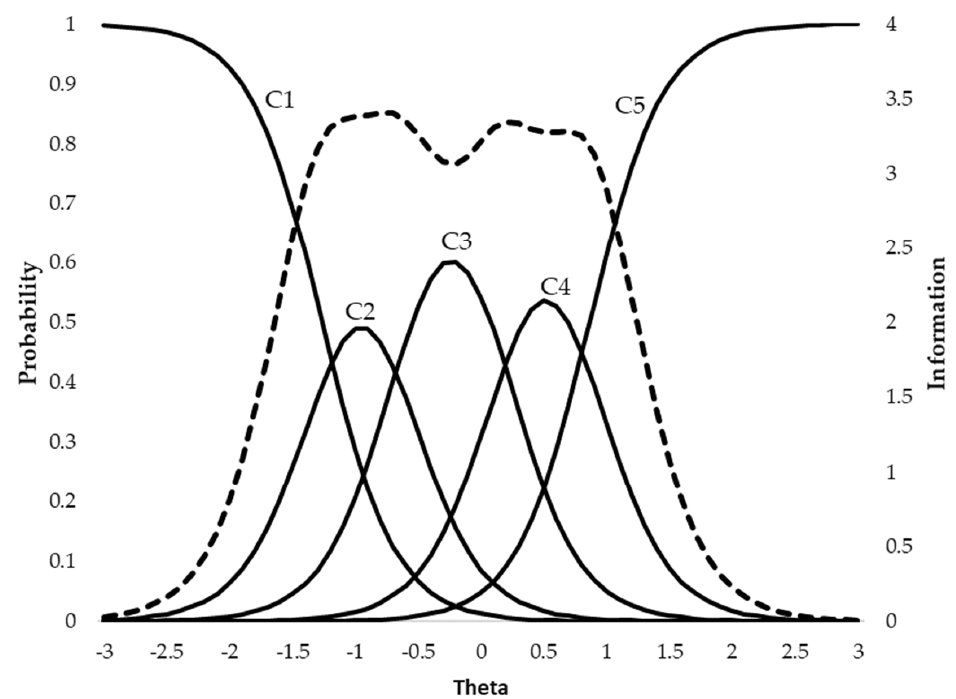
Figure 1. Rating scale categories curves and item information. Solid lines represent the probability of each rating scale category (C1, C2, etc.) conditional to the theta level. The dashed line represents the item information function.